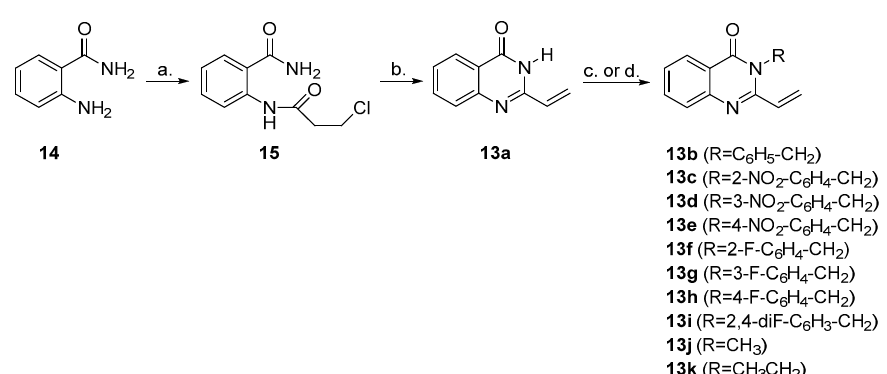
Scheme 2. Synthesis of Compounds 13a – k . Reaction and conditions : a. 3-chloropropionyl chloride, 1,4- dioxane, 0 °C; b. 5% NaOH-EtOH (2:1); c. RBr, KOH, CH 3 CN, 105 °C; d. MeI or EtI, KOH, CH 3 CN, 60 °C.